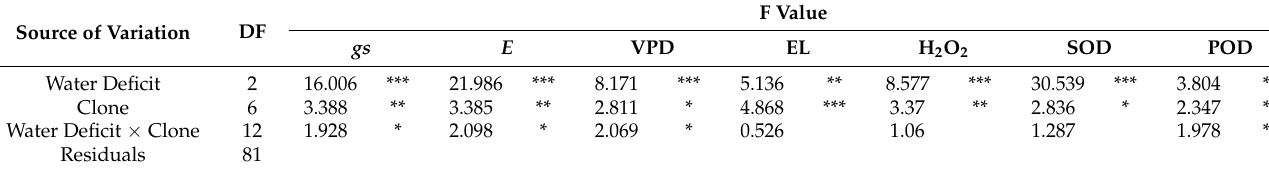
Table 1. The results of the analysis of variance of several ecophysiological and biochemical variables as the effect of water deficit and clone treatment factors. Note: F values followed by ***, **, and * are significant at α = 0.001, 0.01, and 0.05, respectively. DF—degree of freedom, gs —stomatal